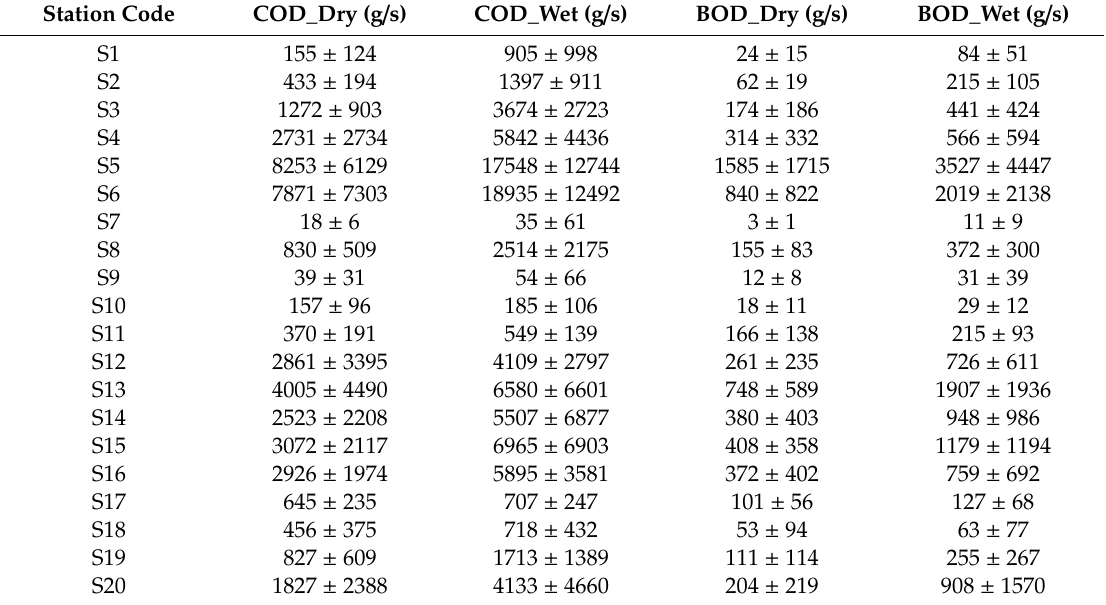
Table 4. Summary of COD and BOD loads in di ff erent seasons at each monitor station in the HRB. Station